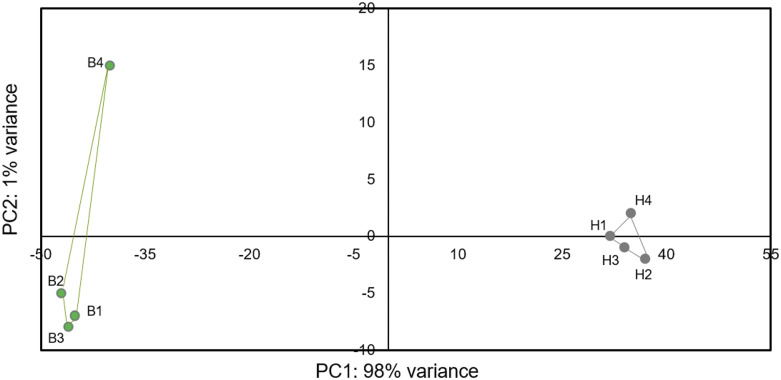
Principal component analysis of regularized-logarithmic (rlog) transformed gene counts of blastospores (B1-4) and hyphal samples (1H-4). Blastospores and hyphae samples are represented by green and gray dots, respectively.